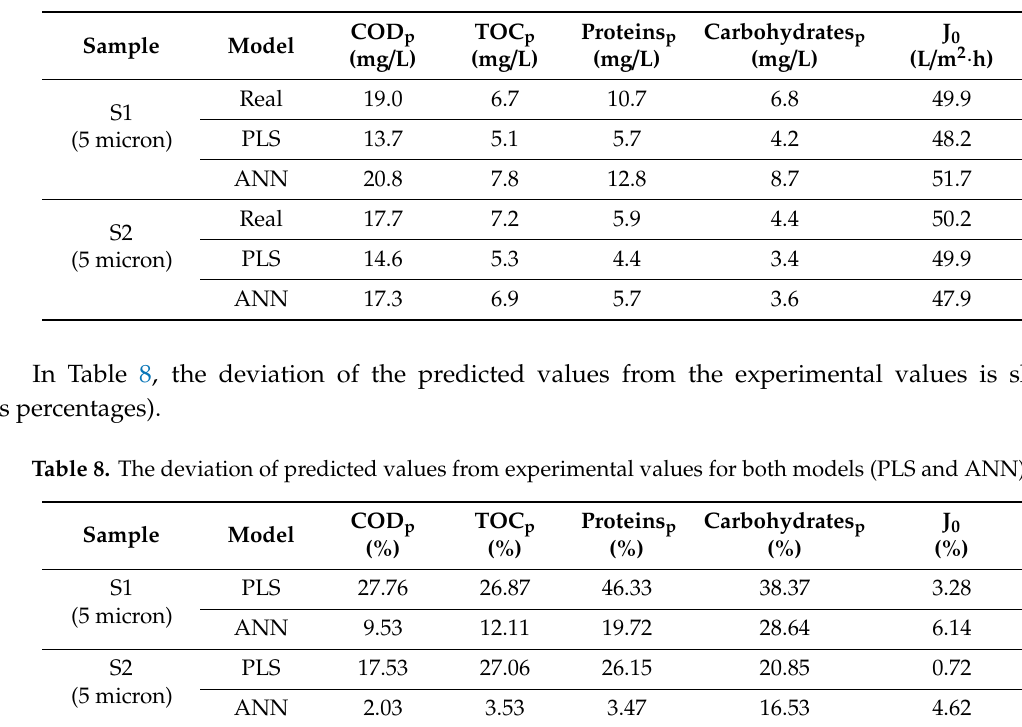
Table 7. Experimental values and predicted for both models (partial least squares (PLS) and artificial neural network (ANN)).